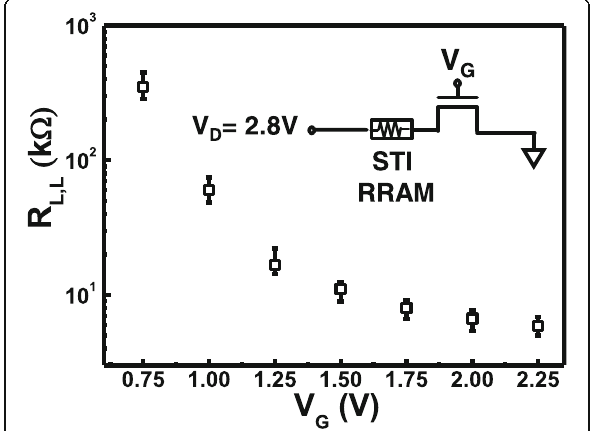
Fig. 3 Correlation between loading resistance levels, R L,L , and the applied gate voltage during set. Data suggest that different R L,L can be obtained by setting a different level of select gate